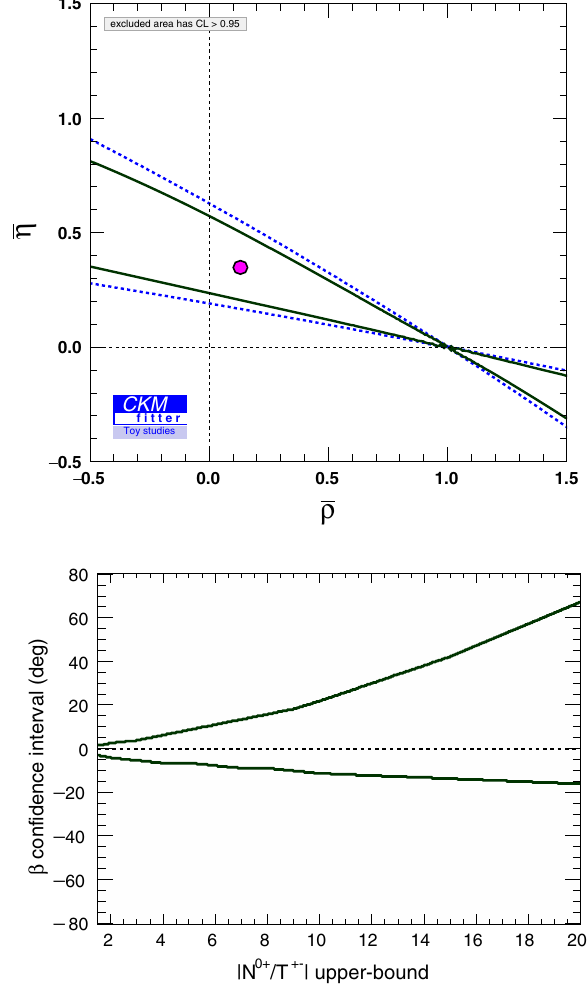
Fig. 2 Top constraintsinthe ¯ ρ – ¯ η planefromtheannihilation/exchange method, using the arbitrary but realistic numerical values for the input parameters detailed in the text. The green solid-line contour is the con- straint obtained by fixing the N 0 + hadronic parameter to its generation value; the blue dotted-line contour is the constraint obtained by set- (cid:17) (cid:17) (cid:17) N 0 + / T +− (cid:17) ratio at twice its generation ting an upper bound on the value. The parameters ¯ ρ and ¯ η are fixed to their current values from the globalCKMfit[6–8],indicatedbythe magentapoint . Bottom sizeofthe β − β | N 0 + / T +− | gen 68% confidence interval vs. the upper bound on in units of its generation